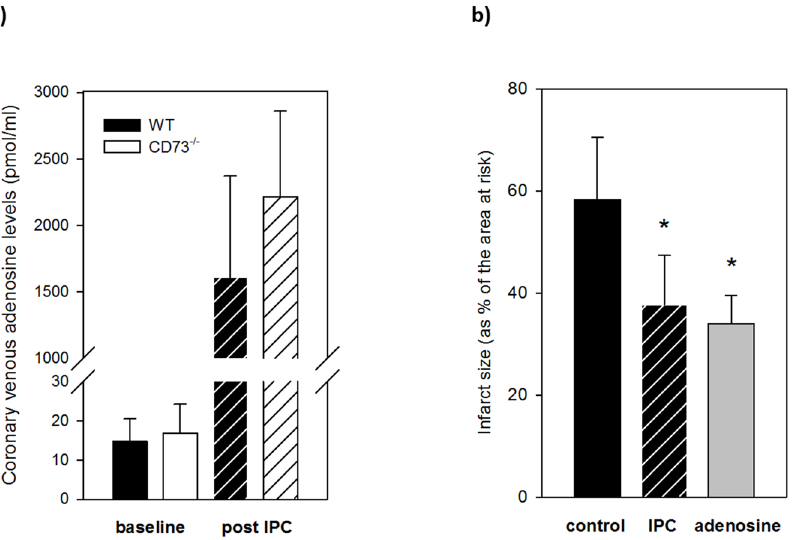
Fig 3. Coronary venous adenosine concentrations and pharmacological preconditioning in vitro . a) Coronary venous adenosine concentrations, baseline and maximum immediately post IPC. There was no significant difference between maximum concentrations in WT (black) and CD73 -/- hearts (white), with even a trend towards higher maximum adenosine outflow in CD73 -/- hearts. n = 7 – 8 each. b) Infarct sizes (as % of the area at risk, here the ventricular myocardium) in isolated saline perfused wild type hearts after pharmacological preconditioning with an intracoronary infusion of 2.5 μ M adenosine (grey bar) for 3x5 minutes in comparison to ischemic preconditioning (IPC, hatched bar) and a control group (black bar). Control n = 8, IPC n = 5, adenosine n = 6, * = p < 0.05 compared to the control